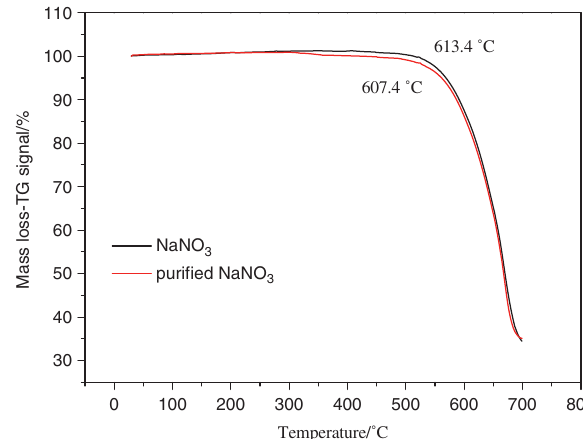
Figure 10: Melting point of Solar Salt and purified Solar Salt after 27 h.